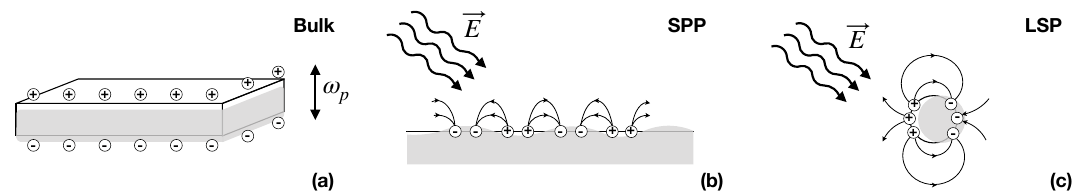
Figure 1. Various types of plasmonic excitations: ( a ) Bulk plasmon in a metallic sample, electronic gas oscillates as a whole with a plasmonic frequency ω p . ( b ) Propagating surface plasmon polariton excited by the external electromagnetic wave. ( c ) Localized surface plasmon excited by the external field in a small metallic nanoparticle. Displacement of the electron gas is shown with light